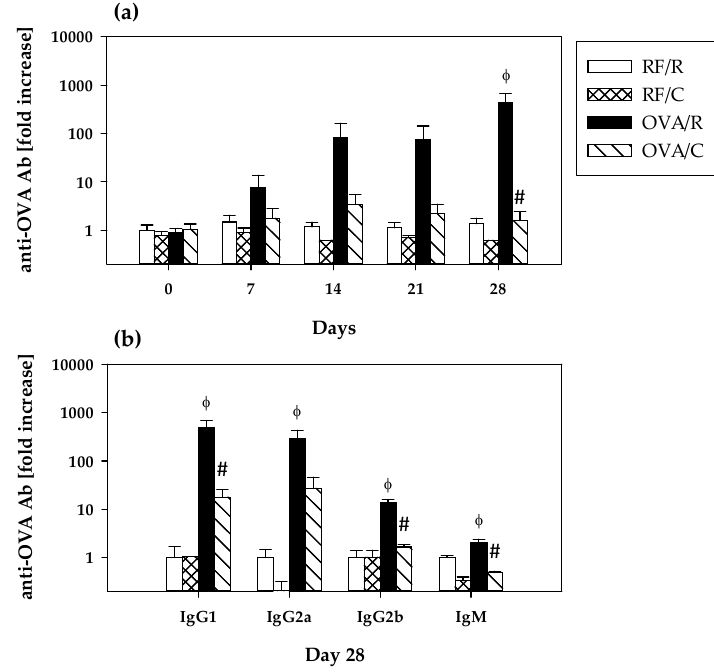
Figure 1. Serum anti-OVA antibodies. ( a ) Total anti-OVA antibody levels throughout the study; ( b ) anti-OVA IgG1, IgG2a, IgG2b, IgM at the end of the study. Values are expressed as mean ± standard error ( n = 9). Statistical differences: φ p < 0.05 compared with RF/R group, and # p < 0.05 compared with OVA/R group by Mann–Whitney U test. Groups: RF/R = reference group; RF/C = reference group fed cocoa diet; OVA/R = sensitized group; OVA/C = sensitized group fed cocoa diet.